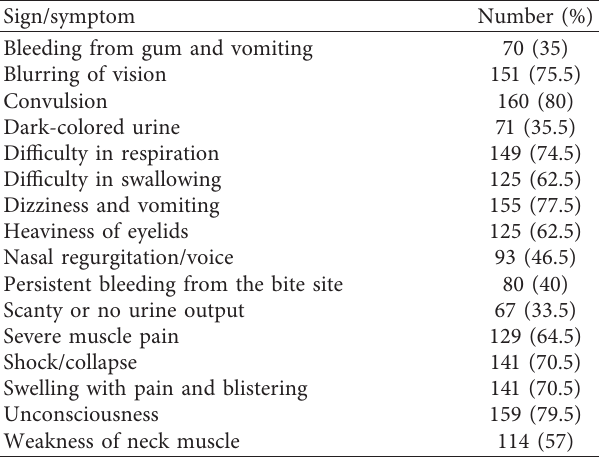
Table 4: Percentages of nursing students who recognized signs and symptoms of snakebites ∗ .